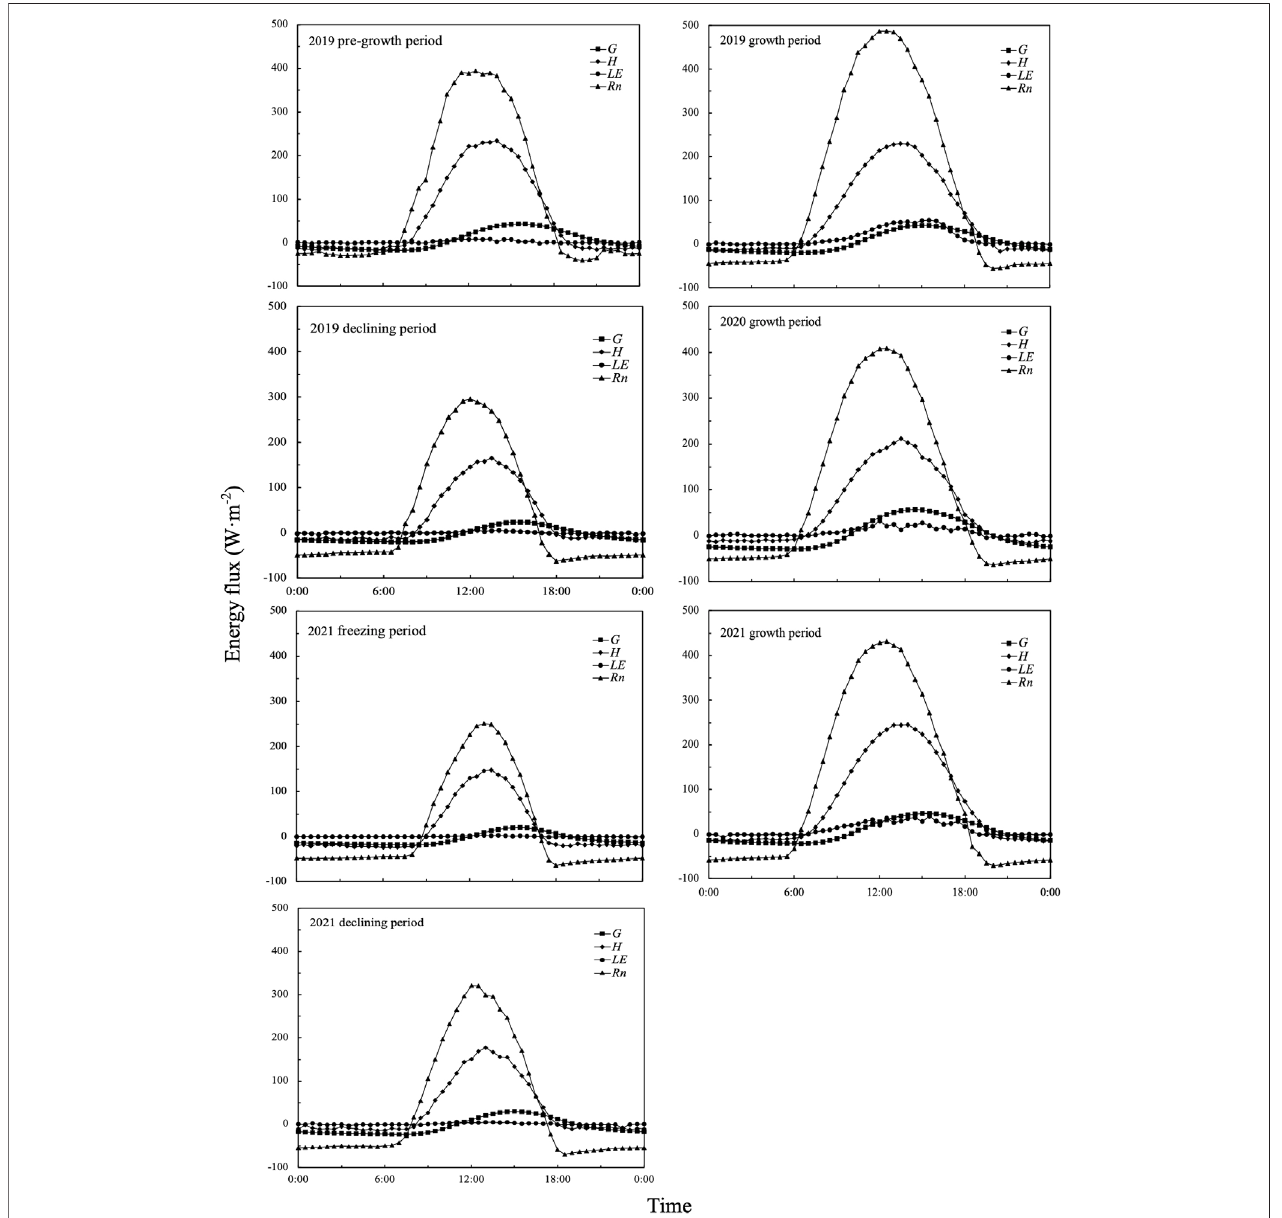
FIGURE 5 | Diurnal variation of energy fl ux in the Inner Mongolian desert ecosystem in different periods.